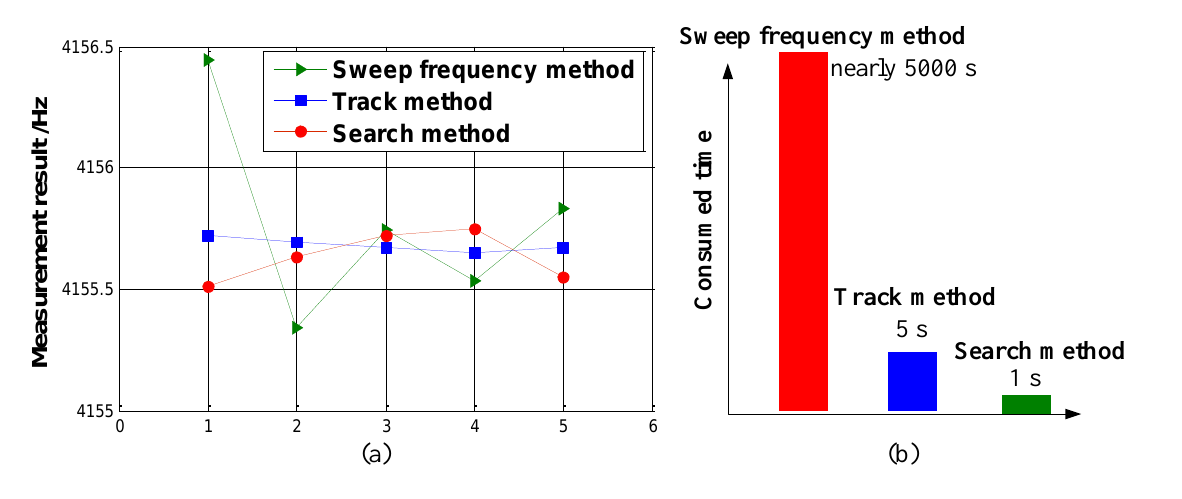
Figure 14. Experimental results of three methods in normal temperature. ( a ) The measurement results. ( b ) Consumed-time comparison.